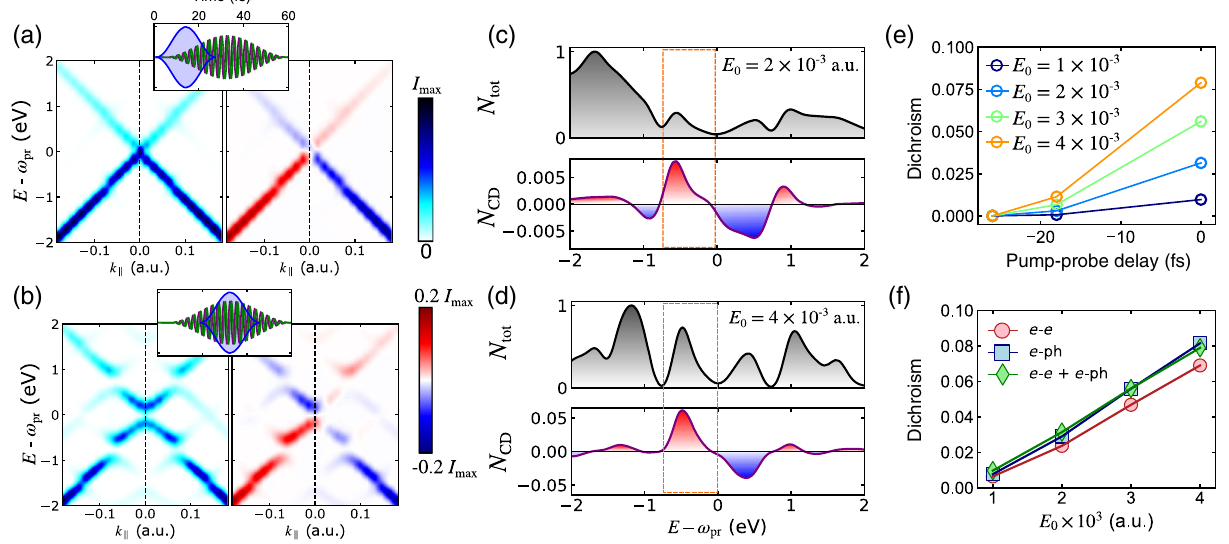
FIG. 6. (a),(b) Build up of Floquet features and circular dichroism in TR-ARPES for Δ t ¼ − 18 fs (a) and Δ t ¼ 0 (b) calculated along the path depicted in Fig. 2(a). All spectra are obtained including e - e and e -ph scattering. The energy E ¼ ε respect to the chemical potential μ . The unpolarized intensity is shown in the left panels, while the dichroic spectra are shown on the right-hand side. (c),(d) Momentum-integrated unpolarized and dichroic TR-ARPES spectra (over a disk around K with k radius) for E 0 ¼ 2 × 10 − 3 (c) and E 0 ¼ 4 × 10 − 3 (d). The orange boxes indicate the range of energy integration for (e) and (f). (e) Relative integrated dichroic signal as a function of the pump-probe delay. (f) Dichroic signal as a function of the pump field